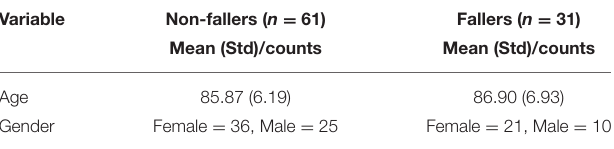
TABLE 1 | Demographic data